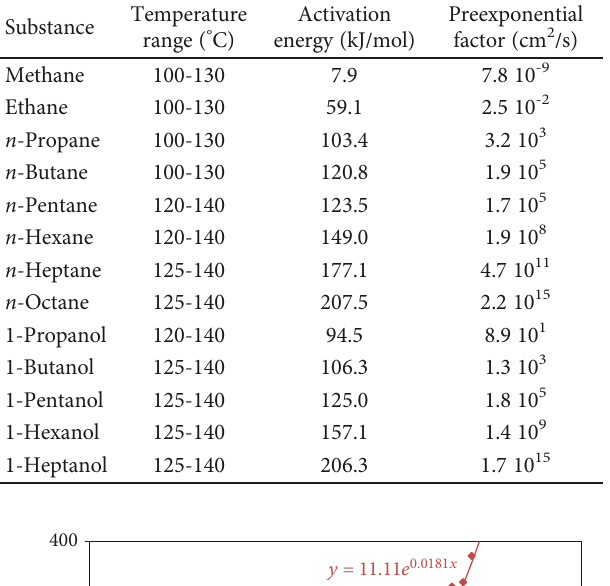
Table 4: Activation energies of di ff usion E factor D derived from di ff usion coe ffi cients from Table 2. 0